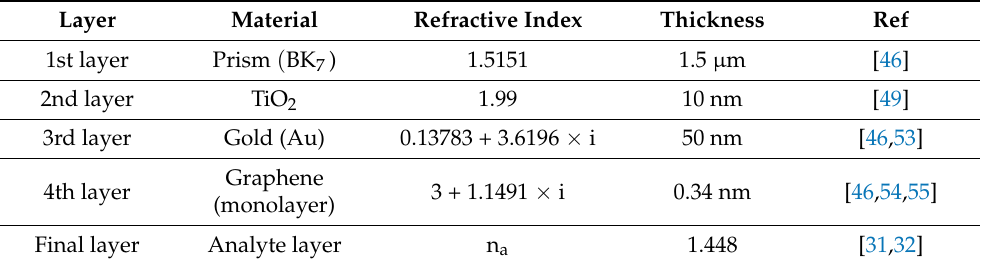
Table 1. Proposed sensor structural design parameter at the wavelength of 633